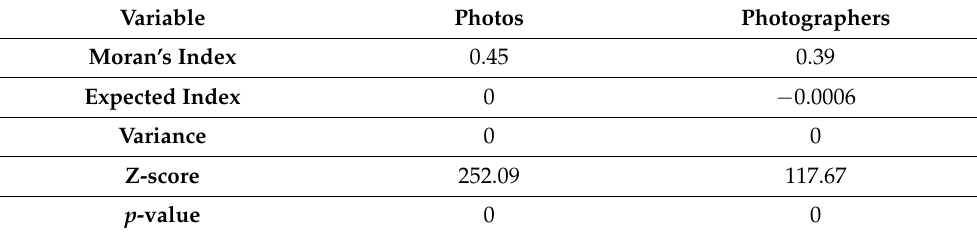
Table 2. Statistical results of Global Moran’s I correlation test for photo- and photographers-based popularity